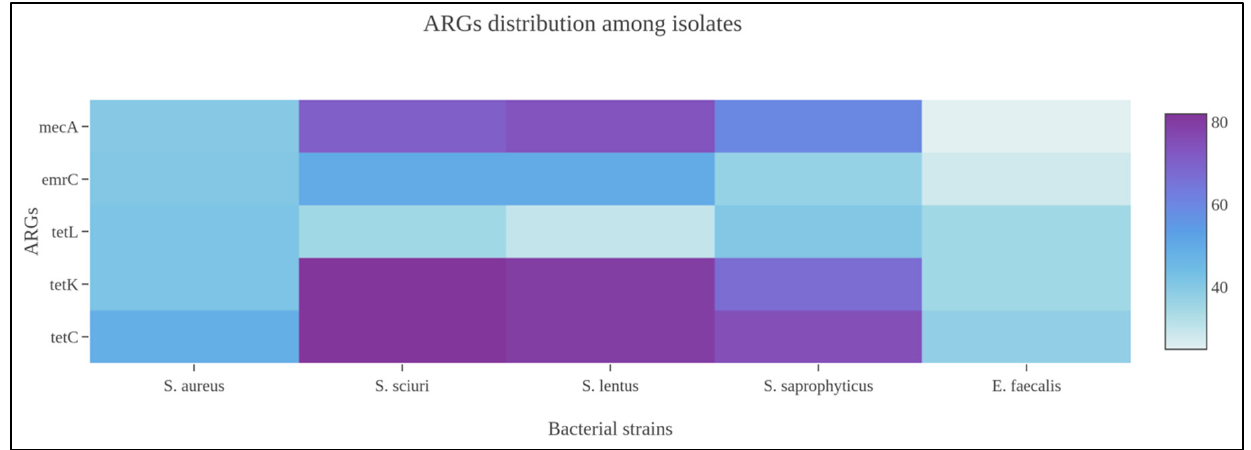
Figure 1. Heatmap representing ARG distribution among Staphylococcus spp. identified in the present scientific investigation.